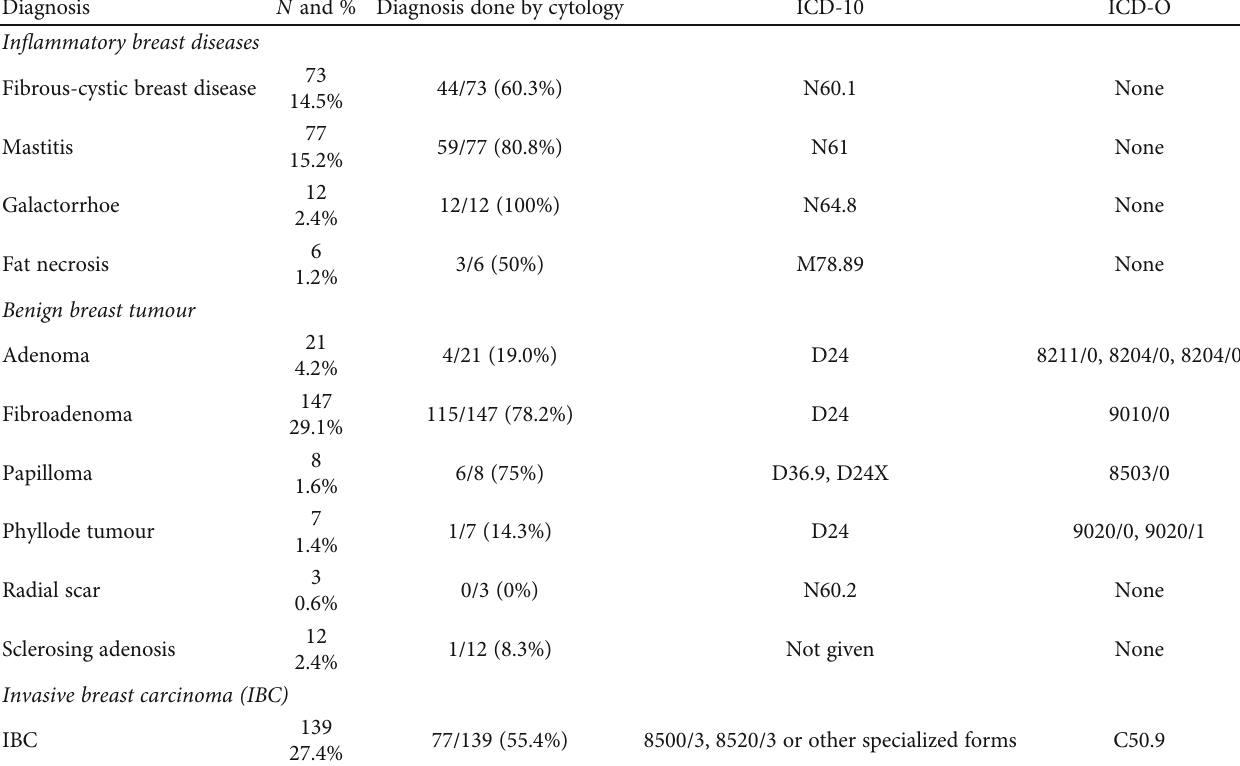
Table 7: Incidence of benign lesions and malignant breast tumours.